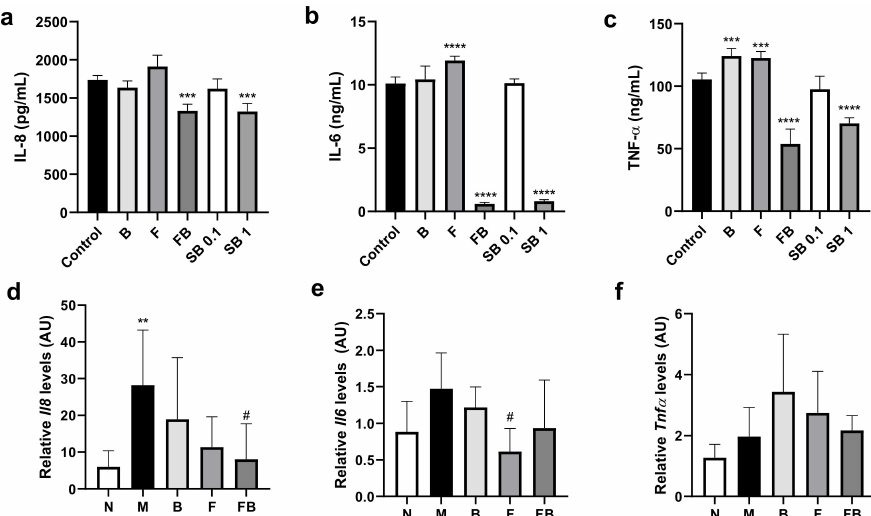
Figure 5. Immunomodulatory e ff ects of bacterial culture supernatants in vitro ( a – c ) and in vivo ( d – f ). ( a – c ) In vitro e ff ect of the culture supernatants: e ff ect on the secretion of IL-8 by LPS-stimulated HT-29 cells ( a ), and on the secretion of IL-6 ( b ) and TNF- α ( c ) by LPS-stimulated RAW 264.7